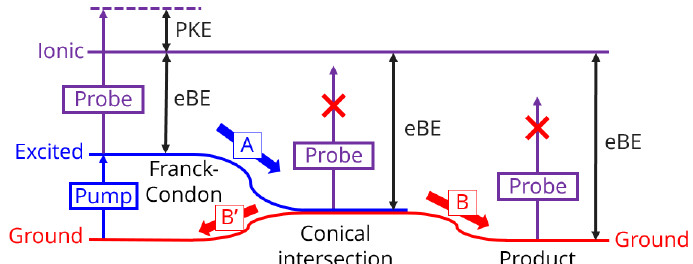
Figure 1. Schematic diagram of time-resolved photoelectron spectroscopy (TRPES). Conical intersections and products with eBE higher than 6 eV have been outside of the observation window when using deep-UV (DUV) probe pulses.